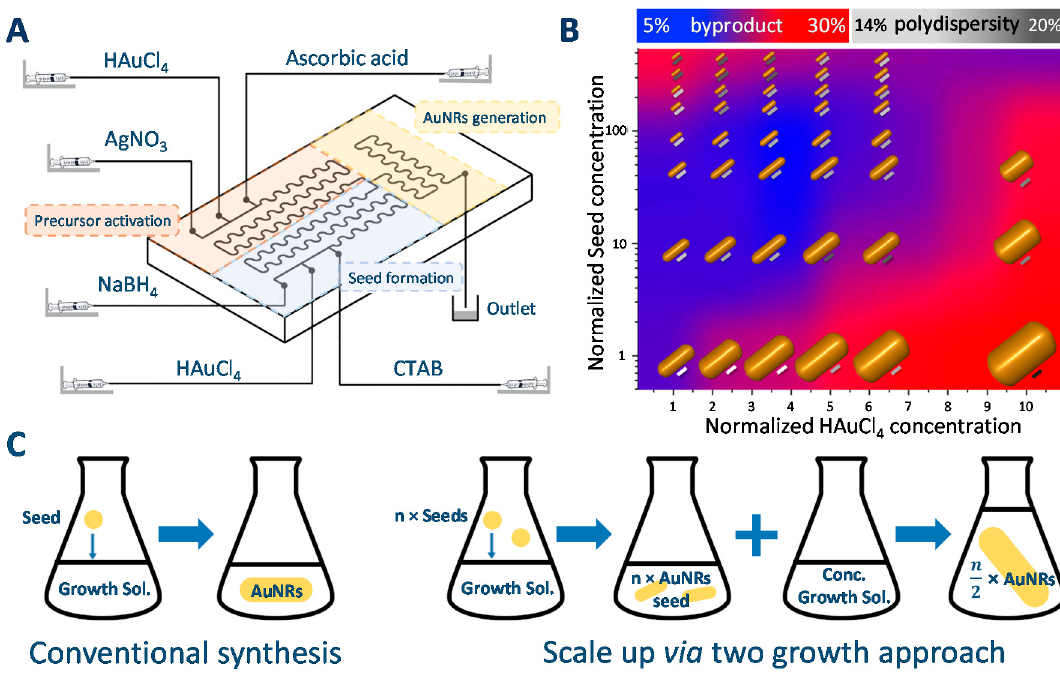
Figure 4. ( A ) Microfluidic flow device allowing better control of reaction parameters and reduction of AuNRs polydispersity. Adapted from [63]. ( B ) Impact of increasing seed and reactant concentration on the structural characteristics of the obtained AuNRs. AuNRs obtained by the conventional seed-mediated protocol is represented as 1 / 1 ratio in seed / HAuCl 4 normalized concentration (polydispersity of AR is reflected by the color of the bar next to the AuNR and product purity by the shade of background color) Adapted from [64]. ( C ) Conventional one-step growth approach (left) compared to the two-step growth approach developed by Park et al. (right) with increasing seeds and second growth solution concentration Adapted from [64].